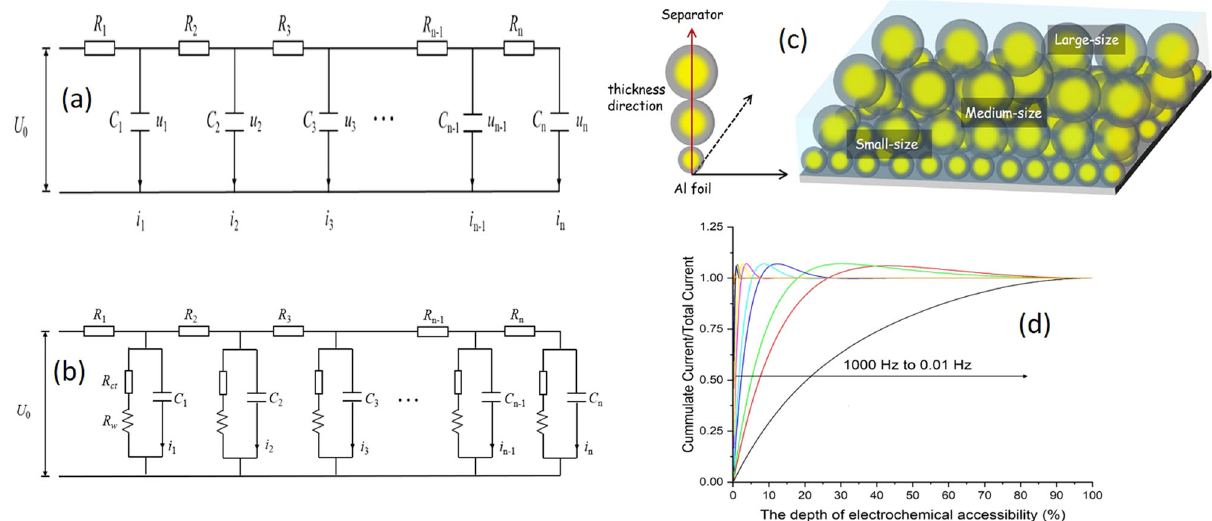
Fig. 5 Transmission line model for porous electrode. a Without charge transfer and b with charge transfer process. c Illustration of porosity-gradient design of thick electrode and d estimation of the penetration depth at different frequencies. This fi gure demonstrates how the transmission line equivalent circuit is used to represent a porous electrode with difference pore structure and related depth of electrochemical asscessibility. (reprinted from ref. 10 . Copyright © 2021, with permission from John Wiley and